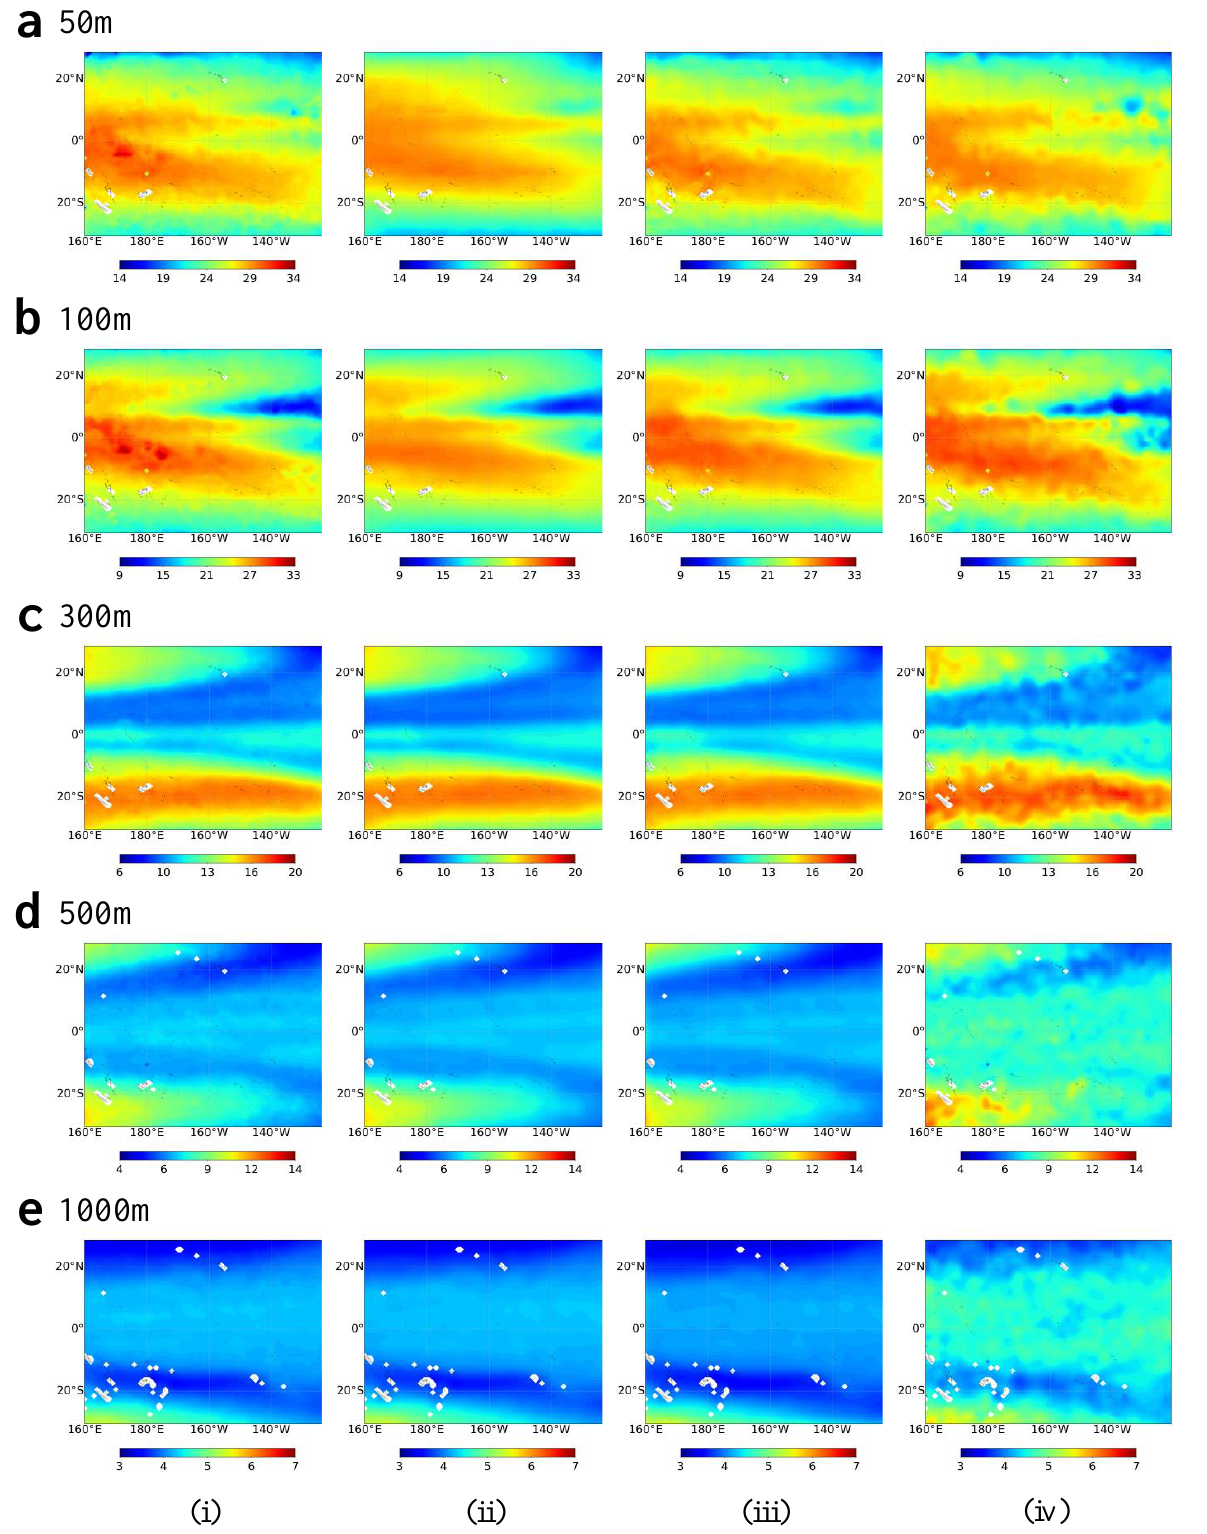
Figure 10. ST spatial distribution of (i) RFs, (ii) LSTM, (iii) ConvLSTM, and (iv) Argo gridded